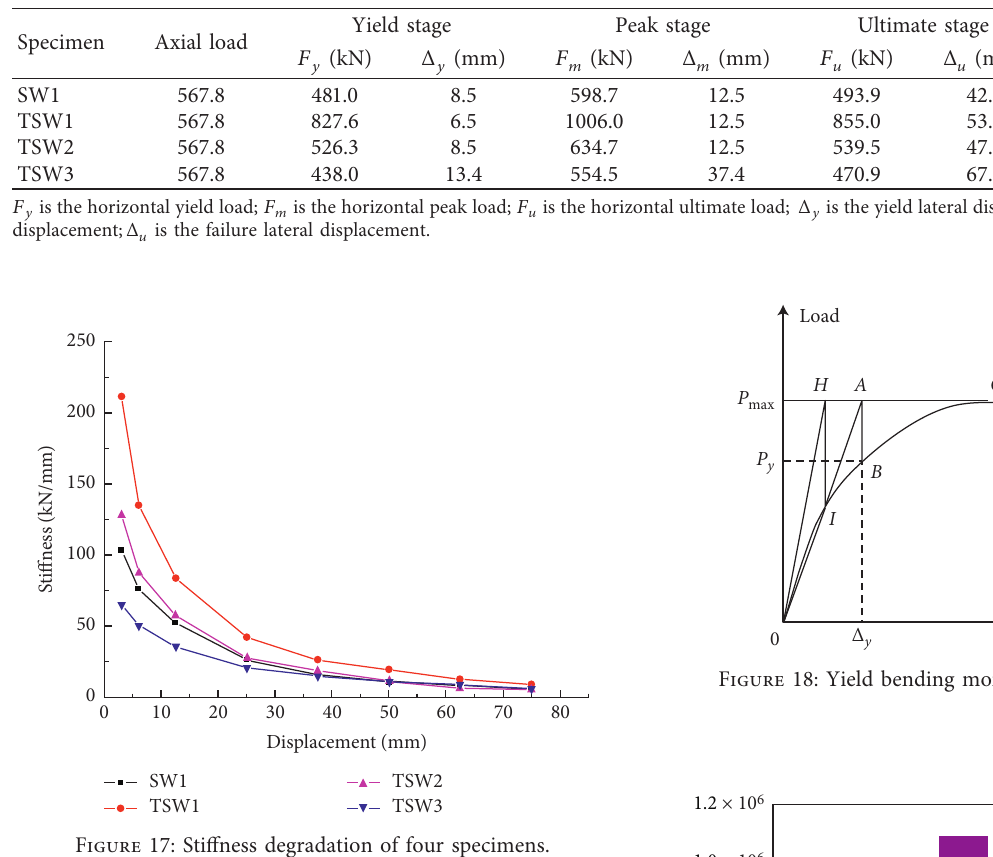
Table 3: Strength characteristics of four specimens at different stages.